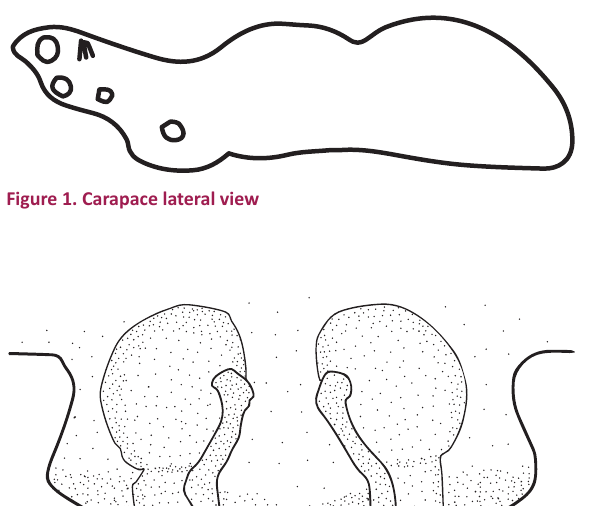
Image 1. Poltys columnaris - motionless female with protruded eye tubercle